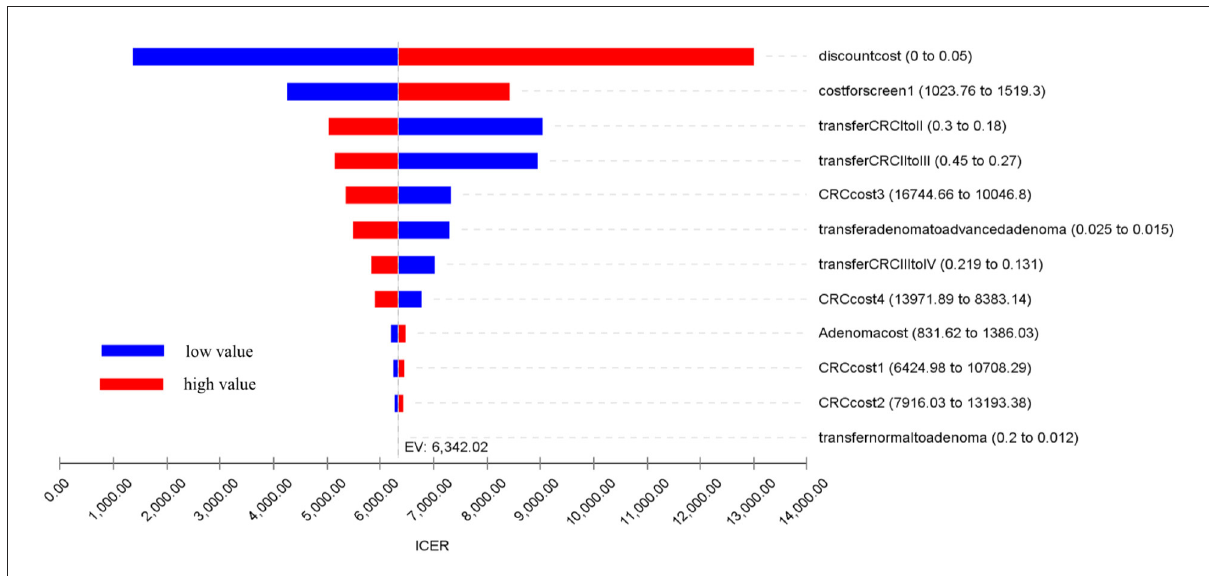
FIGURE4 Tornado diagram of the results of the one-way sensitivity